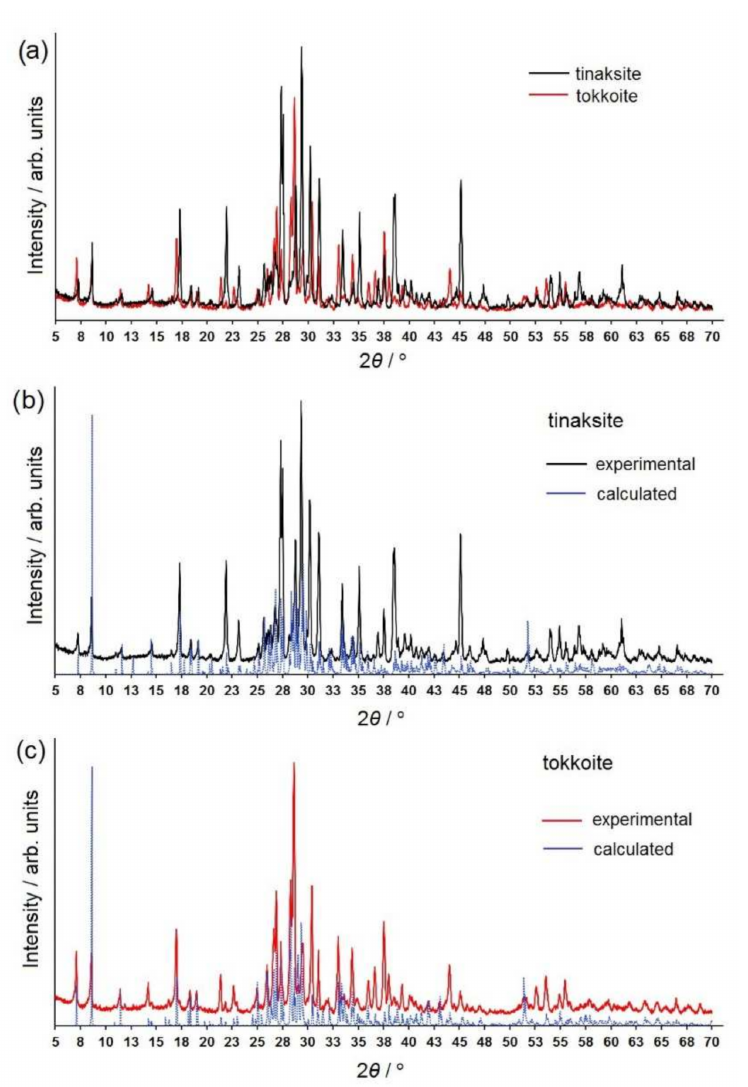
Figure 3. ( a ) X-ray powder diffraction patterns (XRPDP) of tinaksite and tokkoite; ( b ) experimental and calculated XRPDP of tinaksite; ( c ) experimental and calculated XRPDP of tokkoite. The range of 5–70 ◦ 2 θ is